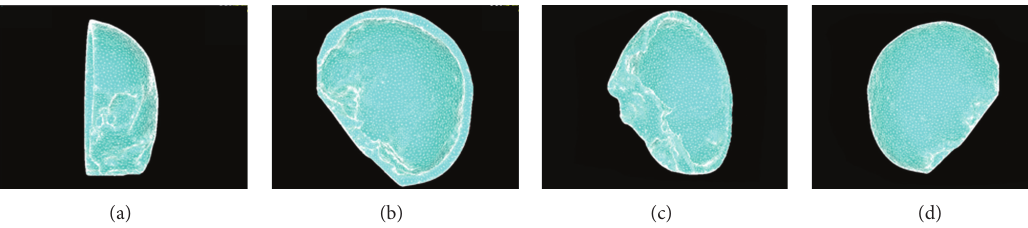
Figure 20: Finite element model of 1/2 cranial cavity.